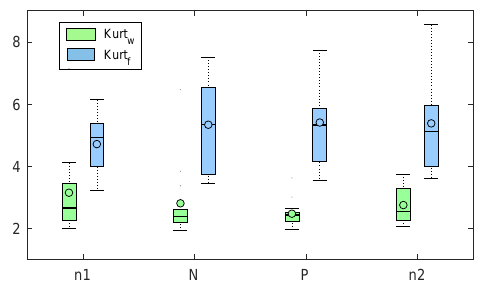
Figure 1. Boxplots related to kurt f (blue) and kurt w (green) values corresponding to the four experimental sessions (n1, N, P, n2).